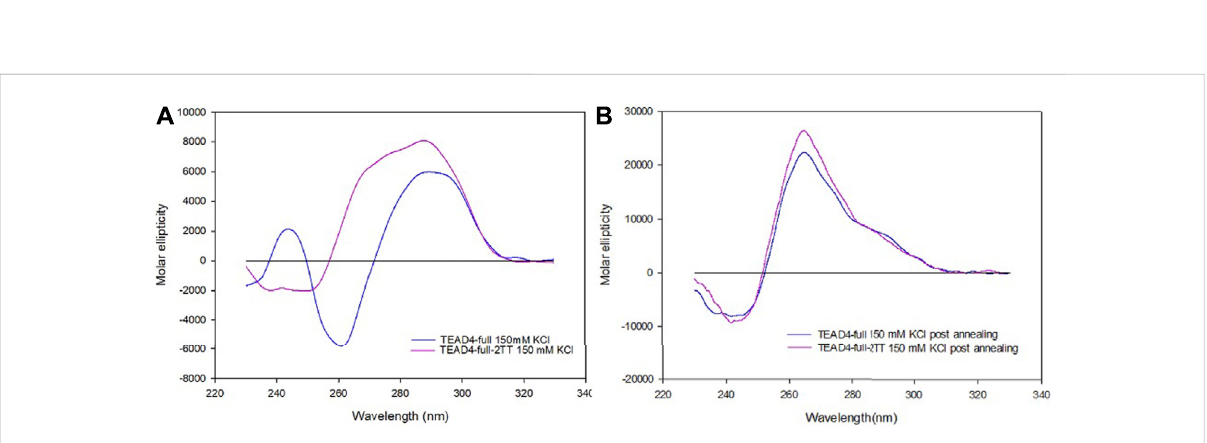
CD spectra of2 µMTEAD4-full and TEAD4-full-2TT in5 mM Tris,pH 7.5, 150 mM KCl acquired 24 h after addition ofthesalt at25 ° C (A) or after annealing (B)